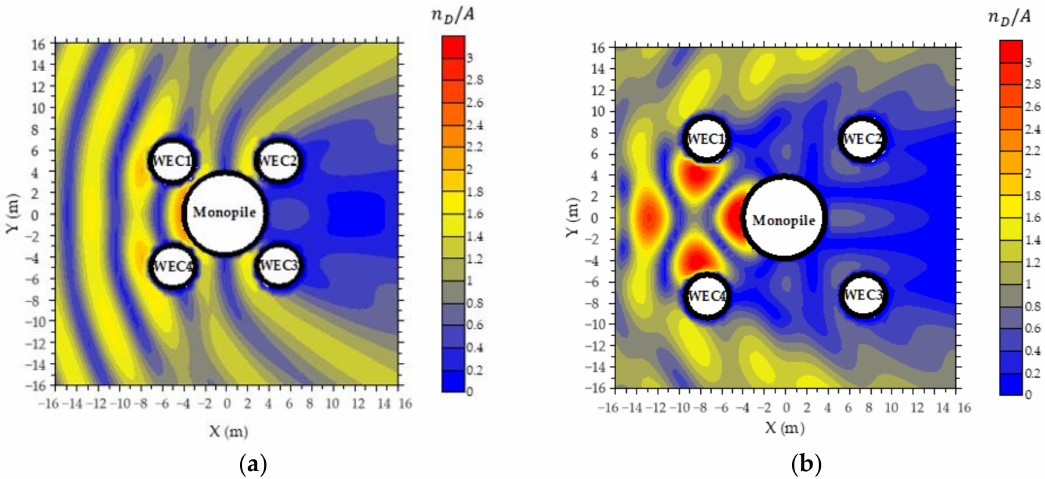
Figure 6. Spatial variation of the non-dimensional wave elevation, n D / A , around the monopile and the oblate spheroidal WECs at ω ≈ 2.6 rad/s and for β = 0 o : ( a ) d net = 0.125 r 0 ; ( b ) d net = 1.0 r 0